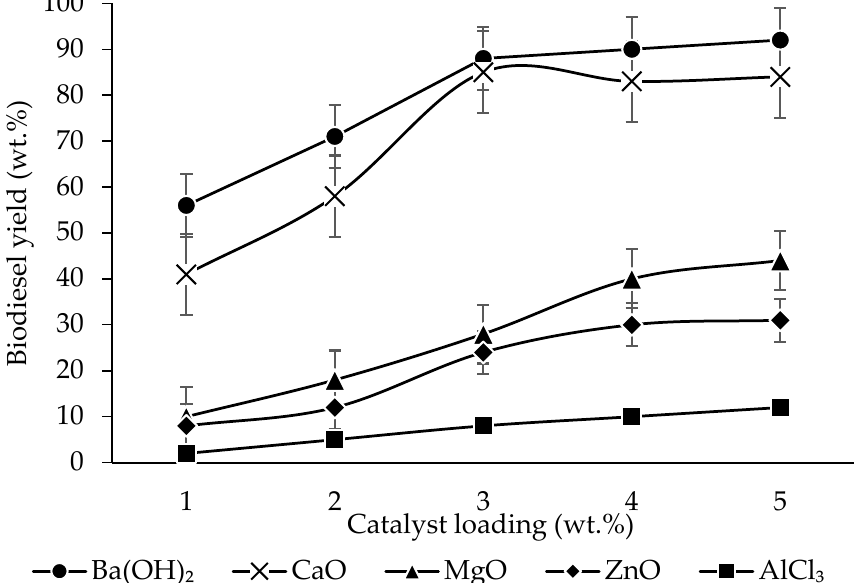
Figure 4. Effect of catalyst type and catalyst dose on biodiesel yield (methanol-to-oil molar ratio of 12:1; temperature 60 °C; time 120 min, speed 600 rpm).